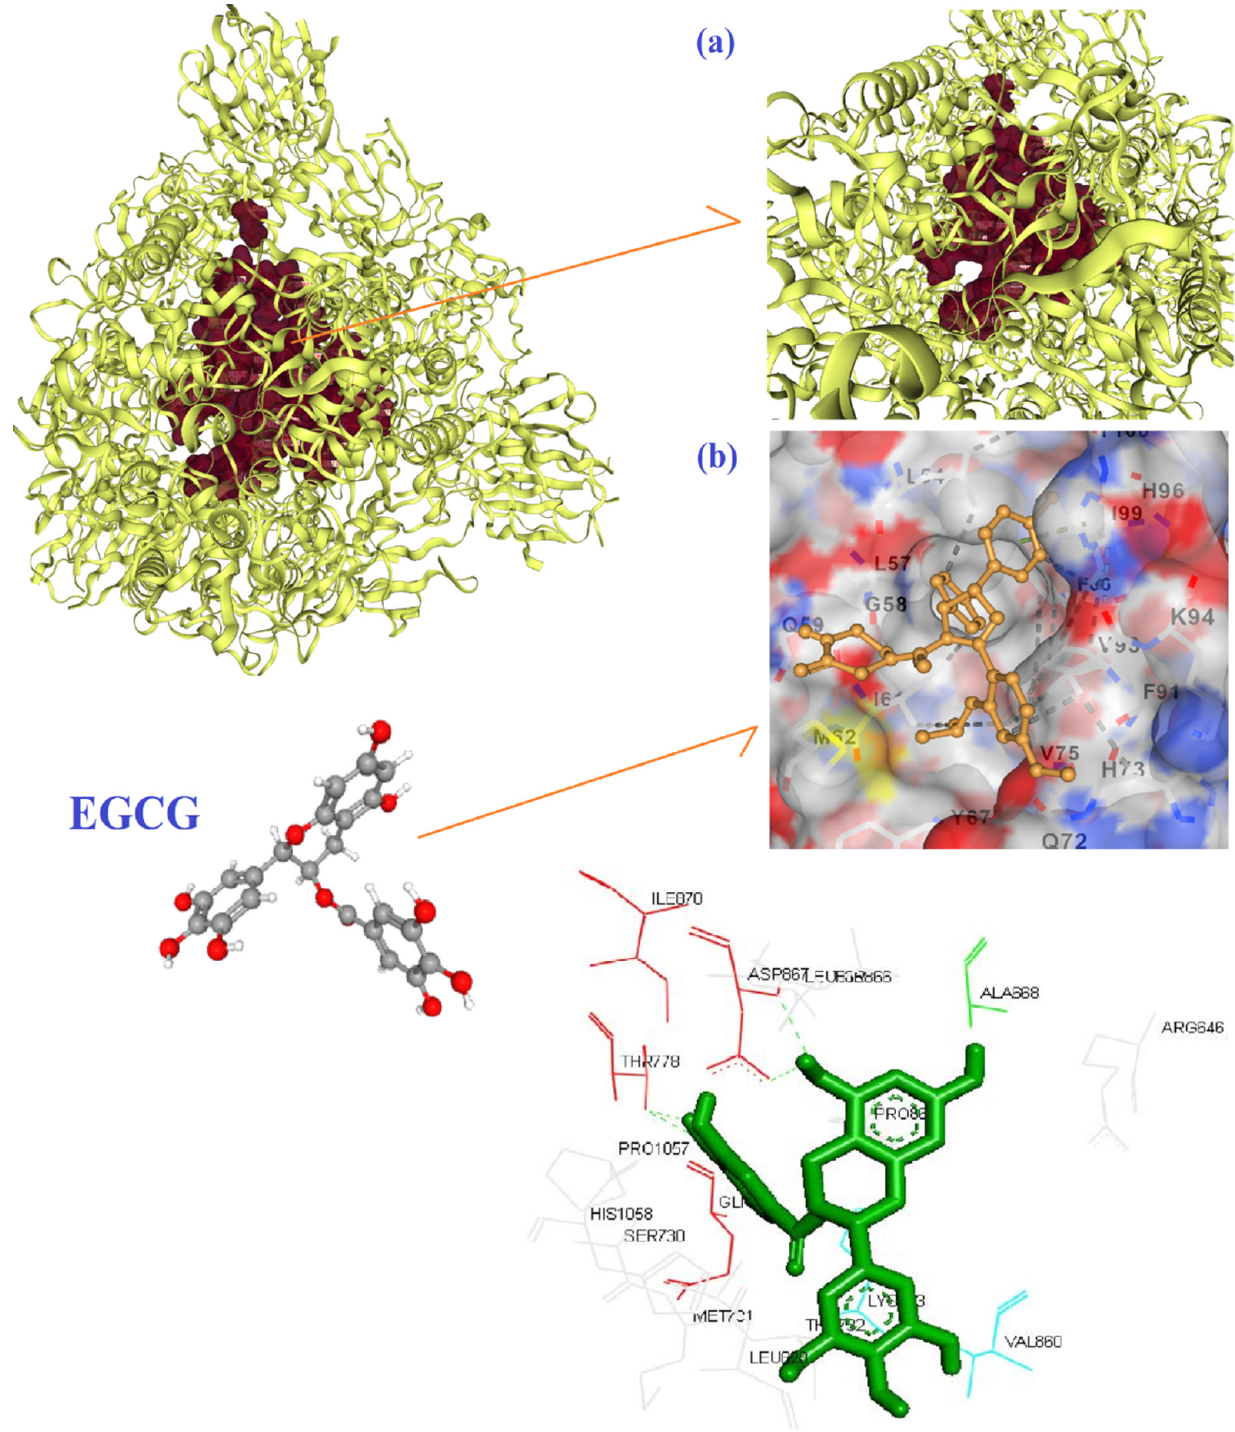
Figure 3. The best mode of the active site for the receptor of 6VSB ( a ) and its interaction with EGCG ( b ) based on the results of CB-Dock.